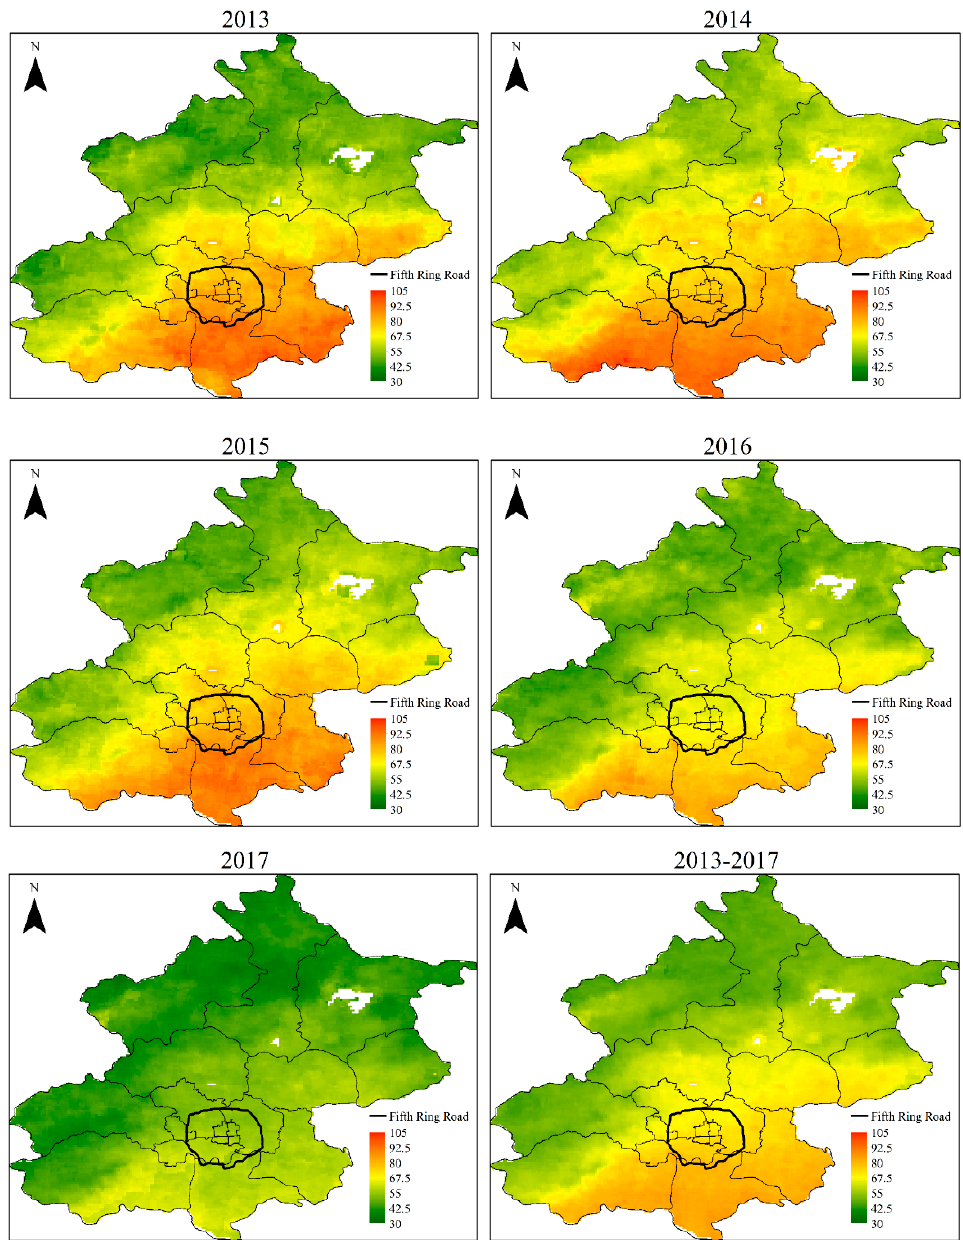
Figure 8. Annual mean PM 2.5 concentration ( µ g/m 3 ) calculated from daily PM 2.5 estimations.